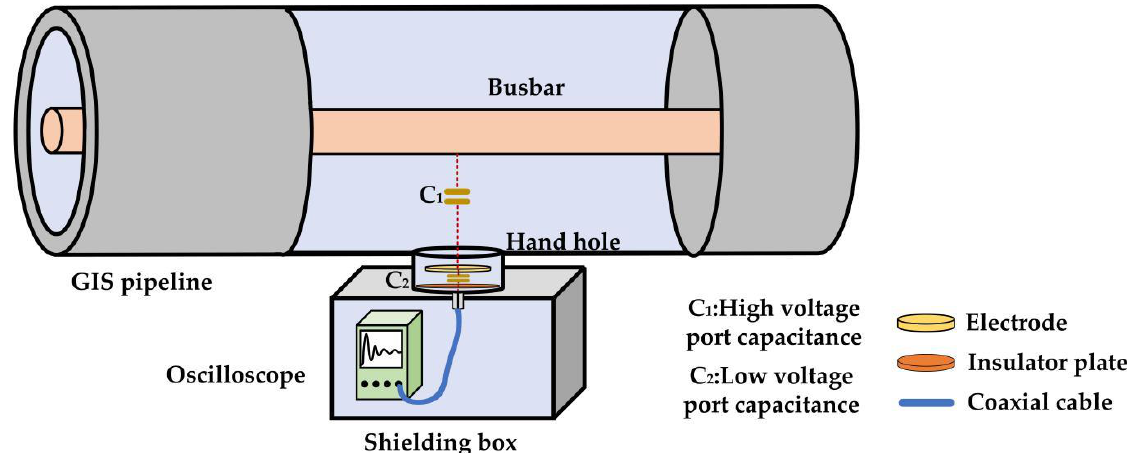
Figure 1. The structure diagram of hand-hole capacitive voltage divider sensor.